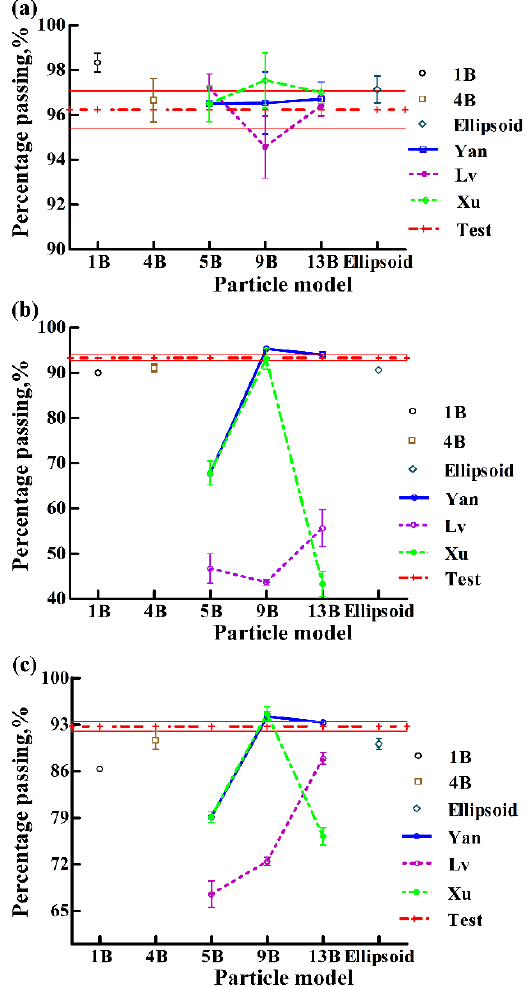
Figure 18. Comparisons between the test results and the simulation results of different models in terms of the percentage passing for soybean particles of ( a ) S-42, ( b ) J-17, and ( c ) Z-39. Processes 2021 , 9 , x FOR PEER REVIEW